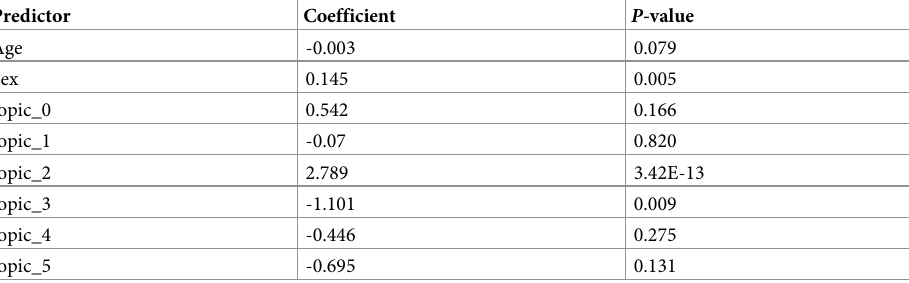
Table 2. Logistic regression analysis between LPA variant for each